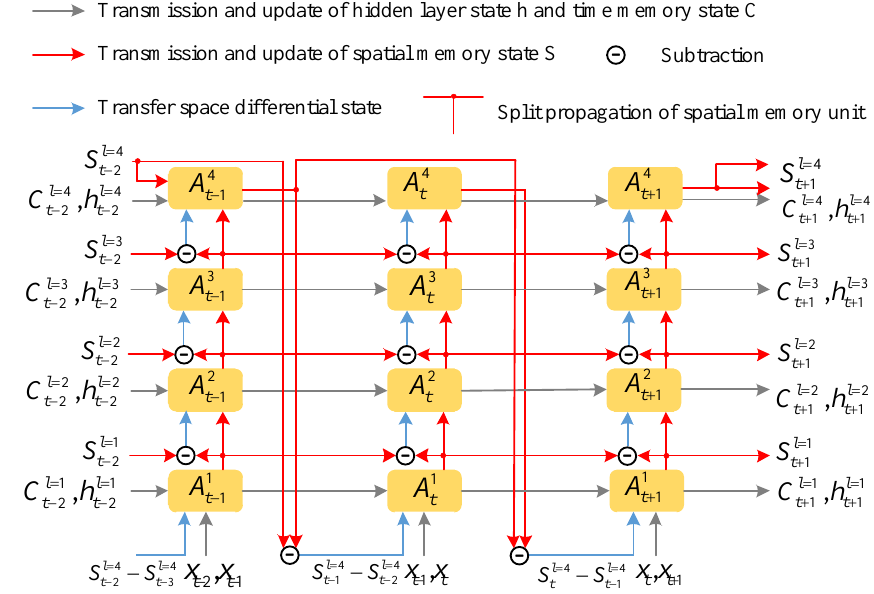
Figure 2. The connection mode between ST-D LSTM